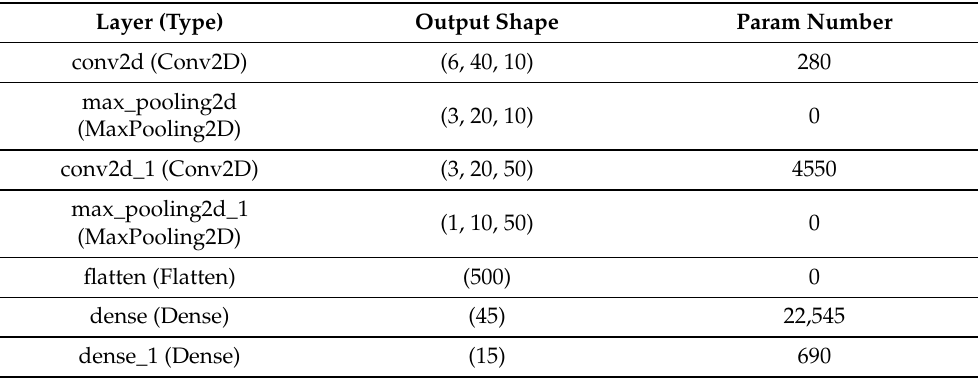
Table 2. Model architecture for the union SNP set. The types and names of the layers of constructed CNN are given in the first column, while the numbers of outgoing connections and the number of trainable parameters are in the second and the last column, respectively (see details in Section 3.6). Layer (Type) Output Shape Param